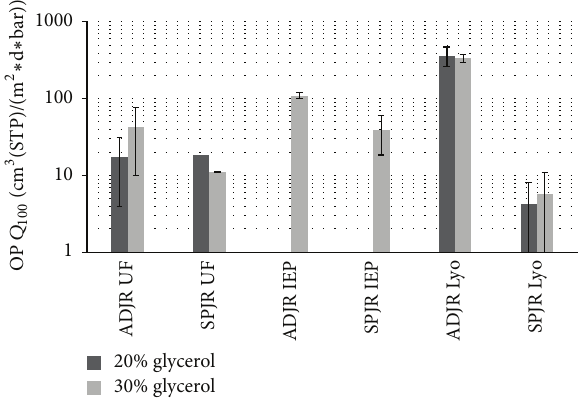
Figure 2: OP of Jatropha protein based films measured at 50% r.h. and 23 ∘